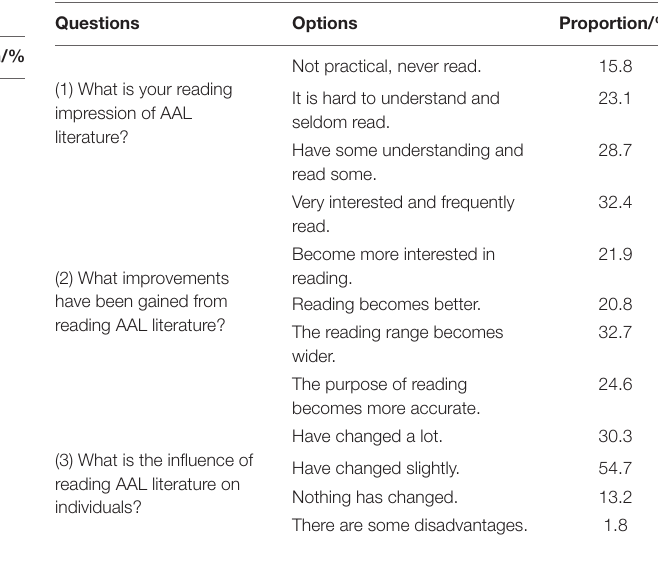
TABLE 5 | Current reading situation of AAL